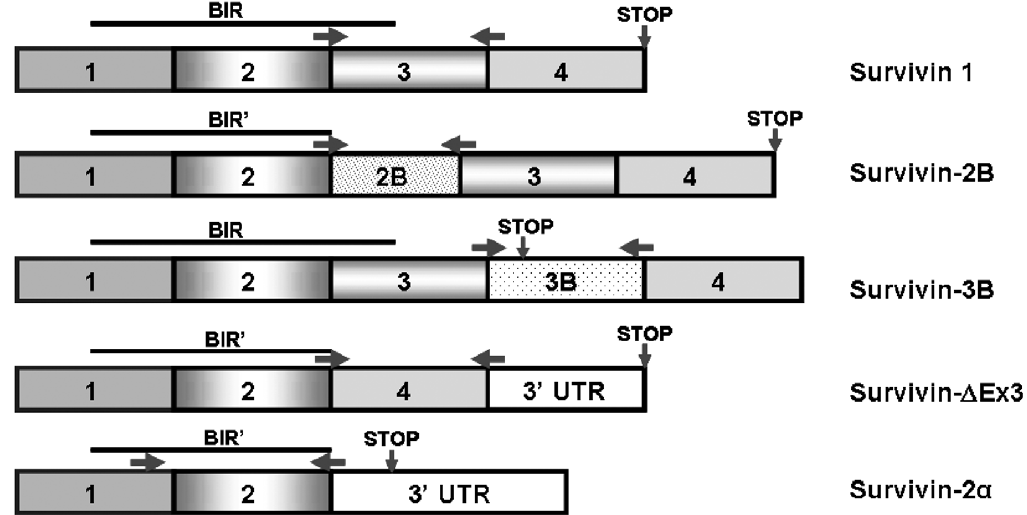
Fig. 1. The exons of the 5 splice variants of survivin. BIR: baculoviral IAP repeat, BIR’: truncated BIR, UTR: Untranslated region. Horizontal arrows indicate primer positions. Perpendicular arrows indicated the site of the stop